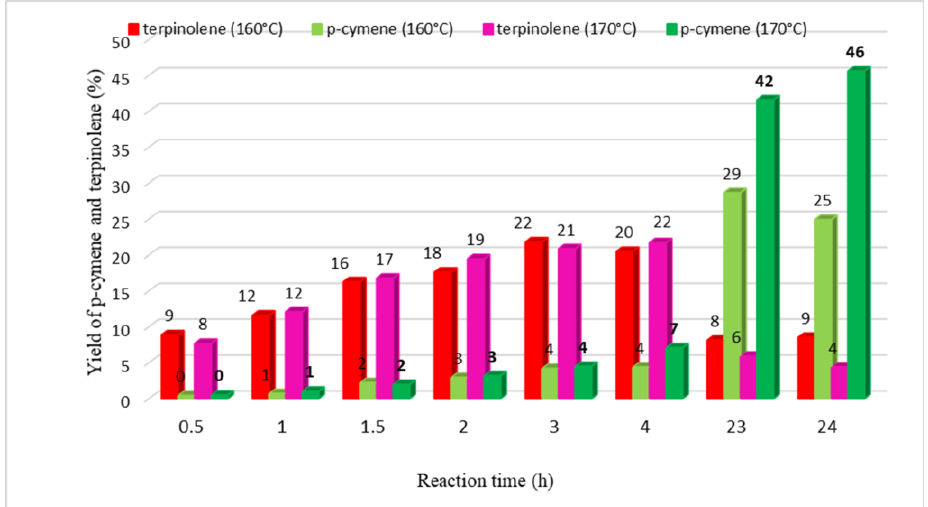
Figure 6. The influence of the temperature (170 °C or 160 °C) on the yields of the main products (terpinolene, p-cymene). Amount of the catalyst was 15 wt% and the reaction time was 0.5, 1, 2, 3, 4, 23 and 24 hours.